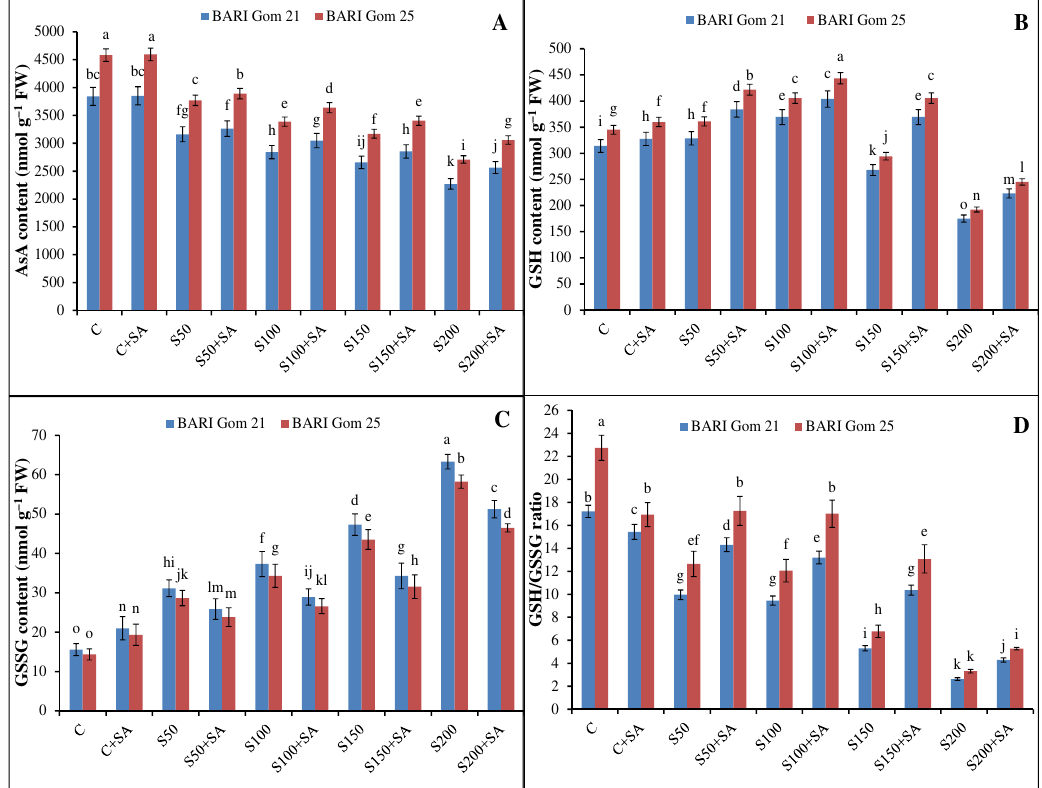
Fig. 2. ( A ) MDA content and ( B ) H O content in salt sensitive and salt tolerant wheat plants induced by exogenous salicylic acid 2 2 under salt stress. S50, S100, S150 and S200 indicate 50 mM, 100 mM, 150 mM and 200 mM NaCl, respectively. SA indicates 1 mM salicylic acid spray, respectively. Mean (±SD) was calculated from three replicates for each treatment. Values in a column with different letters are significantly different at p ≤ 0.05 applying LSD test